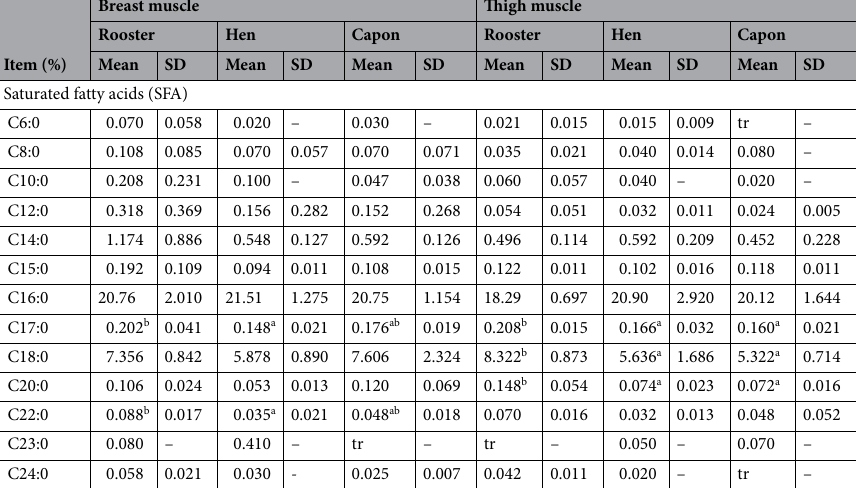
Table 2. Saturated fatty acid profile of analysed muscles. a,b Mean values in the row (among particular muscle) differ significantly at p ≤ 0.05; SD standard deviation, C 6:0—caproic acid, C8:0—caprylic acid, C10:0—capric acid, C12:0—lauric acid, C14:0—myristic acid, C15:0—pentadecylic acid, C16:0- palmitic acid, C17:0— margaric acid, C18:0—stearic acid, C20:0—arachidic acid, C22:0—behenic acid, C23:0—tricosanoic acid, C24:0—lignoceric acid.